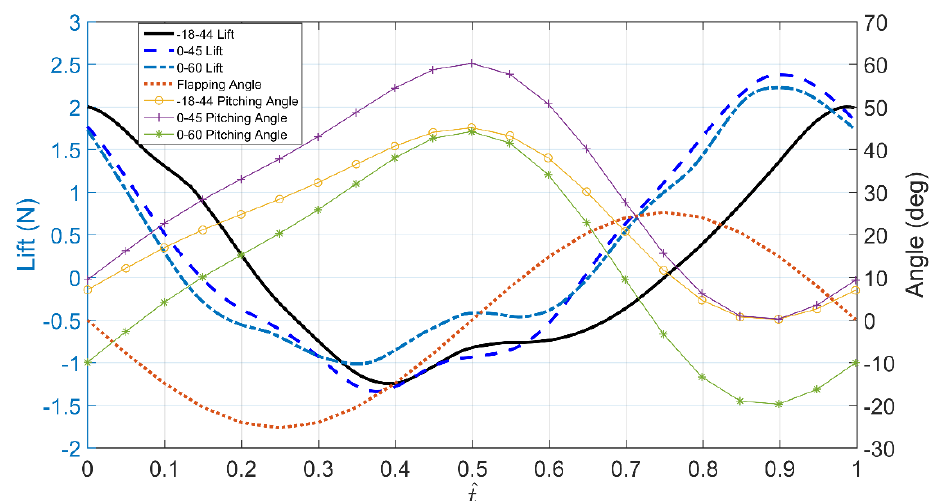
Figure 15. The lift forces of the flapping wing in three cases of pitching angle variation.